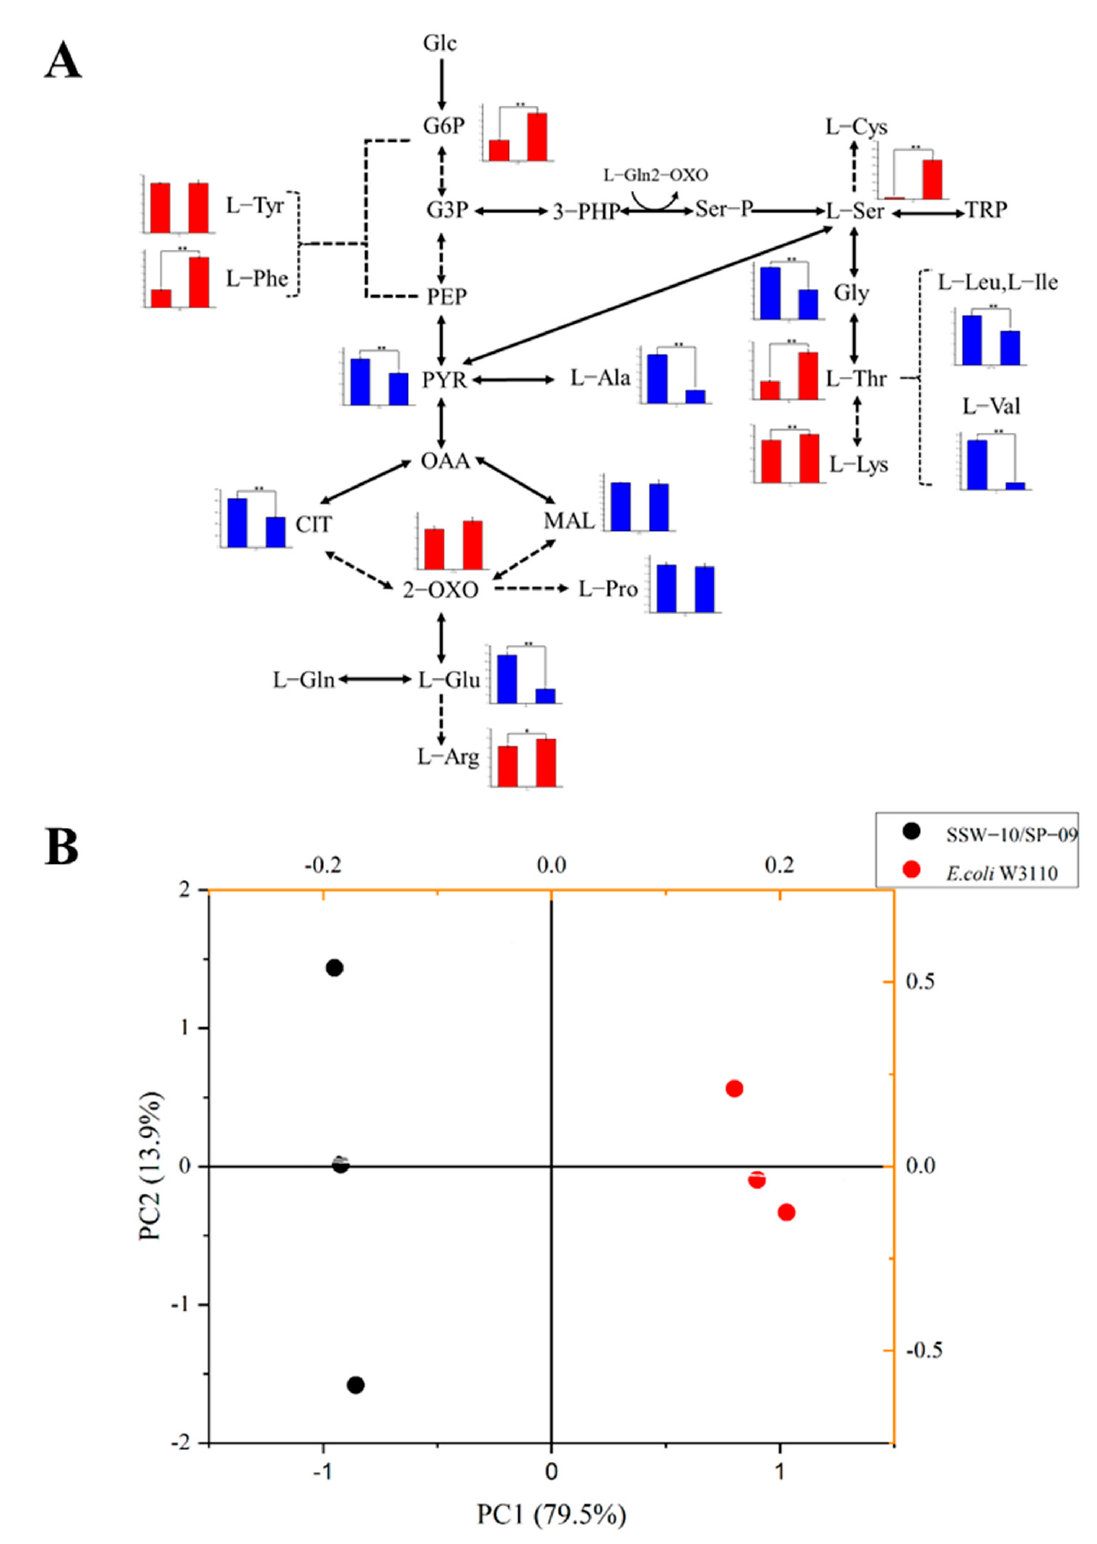
Figure 7. The PCA score and intracellular metabolites of SSW-10/SP-09 and E. coli W3110. ( A ) Sev- enteen intracellular metabolites of SSW-10/SP-09 and E. coli W3110 (three independent replicates). Significant changes in cofactors are represented by * ( p < 0.05) and ** ( p < 0.01). ( B ) PCA score.